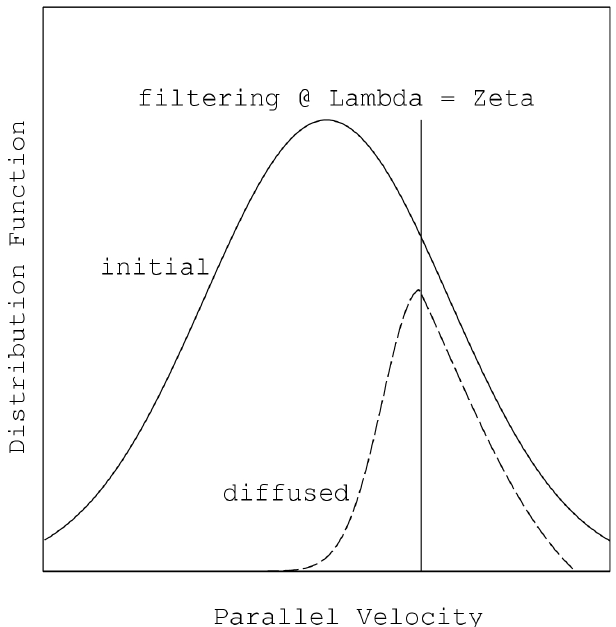
Fig. 13. Schematic view of the filtering effect acting upon the initial ion distribution function to produce a D-shaped